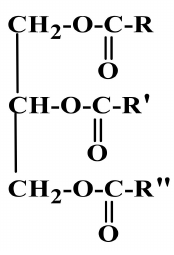
Figure 6. General chemical structure of palm oil (-R can be represented by palmitic, stearic, myristic, oleic, and linoleic).